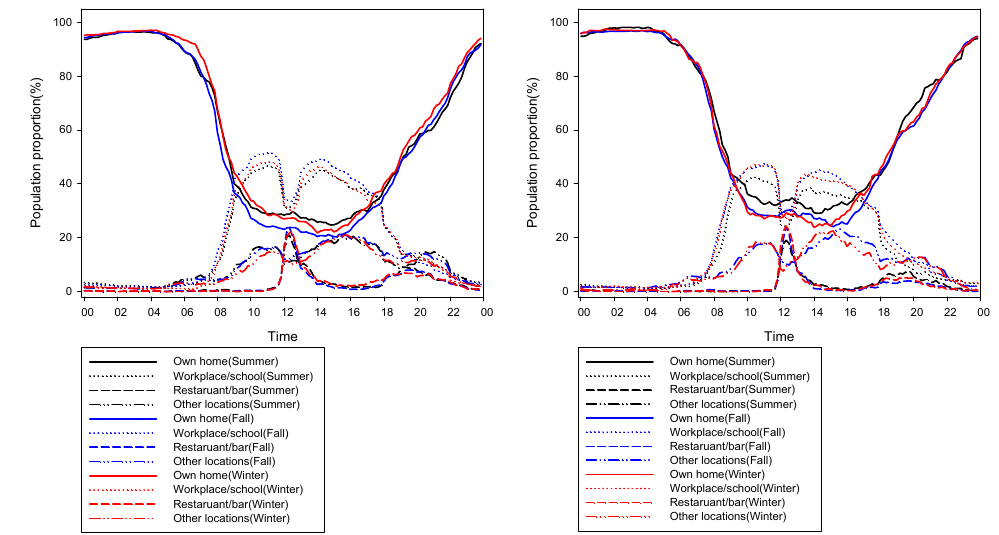
Figure 1 . Percentage of Seoul ( Left ) and Busan ( Right ) participants in 4 locations by the time of day over three seasons.